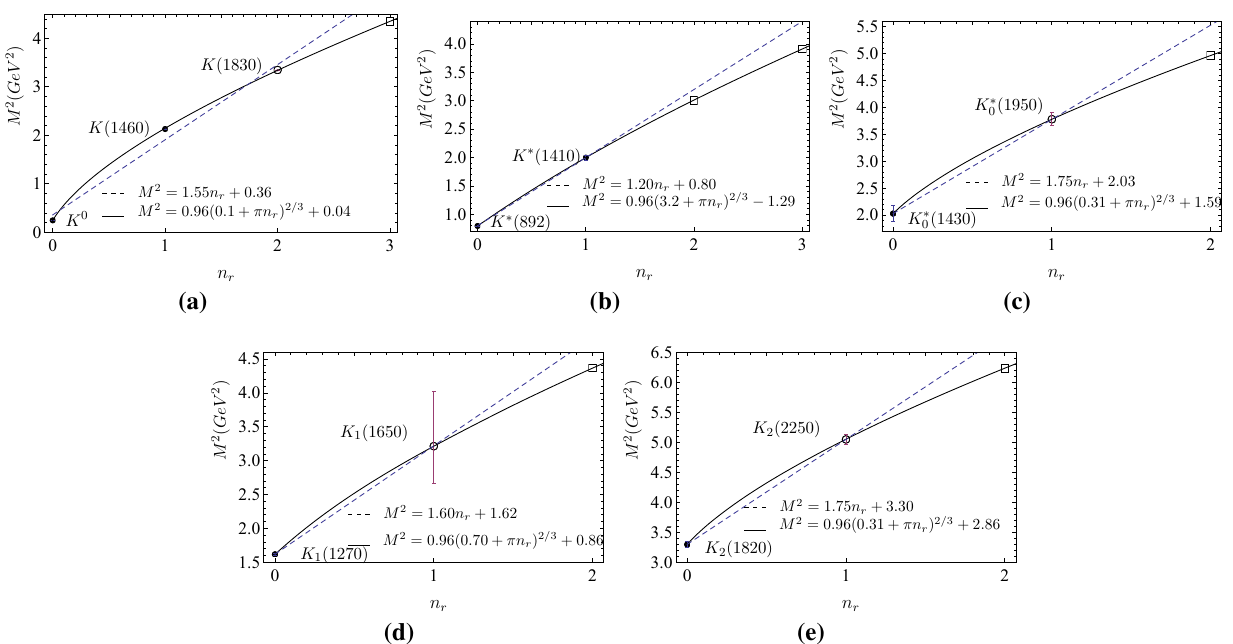
Fig. 1 The radial Regge trajectories for the strange mesons. The used data are listed in Table 1. The well-established states are given by the solid dots. The unwell-established states or the states needing confir-